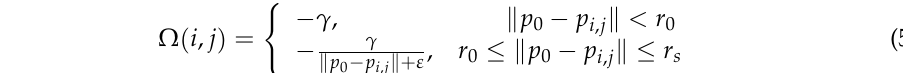
Figure 7. Probability distribution of the local search space with obstacles in polar coordinates. 3. Collision-Free Path Generation Based on the above local search space design, the problem of collision-free path plan- ning can be transformed into the problem of node selection, i.e., the nodes are selected and connected one by one along the arcs that gradually expand from near to far in the search area and in the meantime ensure that the connecting lines do not intersect with obstacles (see Figure 8).